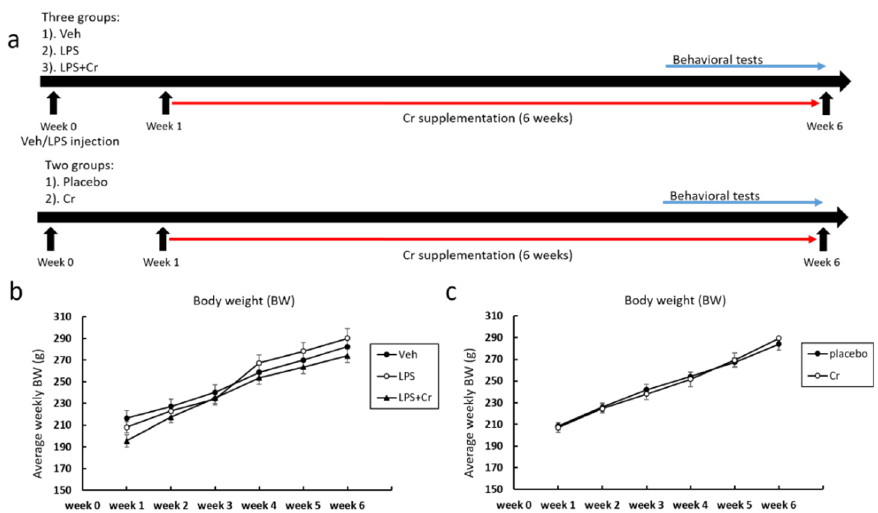
Figure 1. Experimental timeline, changes of bodyweight across the experiment. ( a ) Experimental timeline for the study, where the LPS experiment (experiment 1) has three groups: Veh, LPS and LPS + Cr. All groups underwent either Veh or LPS injection through stereotactic surgery. Creatine (Cr) supplementation or placebo started at week 1 lasting for 6 weeks, and behavioral tests occurred at the last five days of the experiment; Non-LPS (experiment 2) experimental rats were divided into two groups: placebo and Cr group. All rats started Cr or placebo beginning week 1 lasting for 6 weeks, and behavioral tests occurred at the last five days of the experiment. ( b , c ) Average weekly BW for each week of the study in both LPS ( b ) and non-LPS ( c ) experiment. Results are presented as mean ± SEM ( n = 12/group).